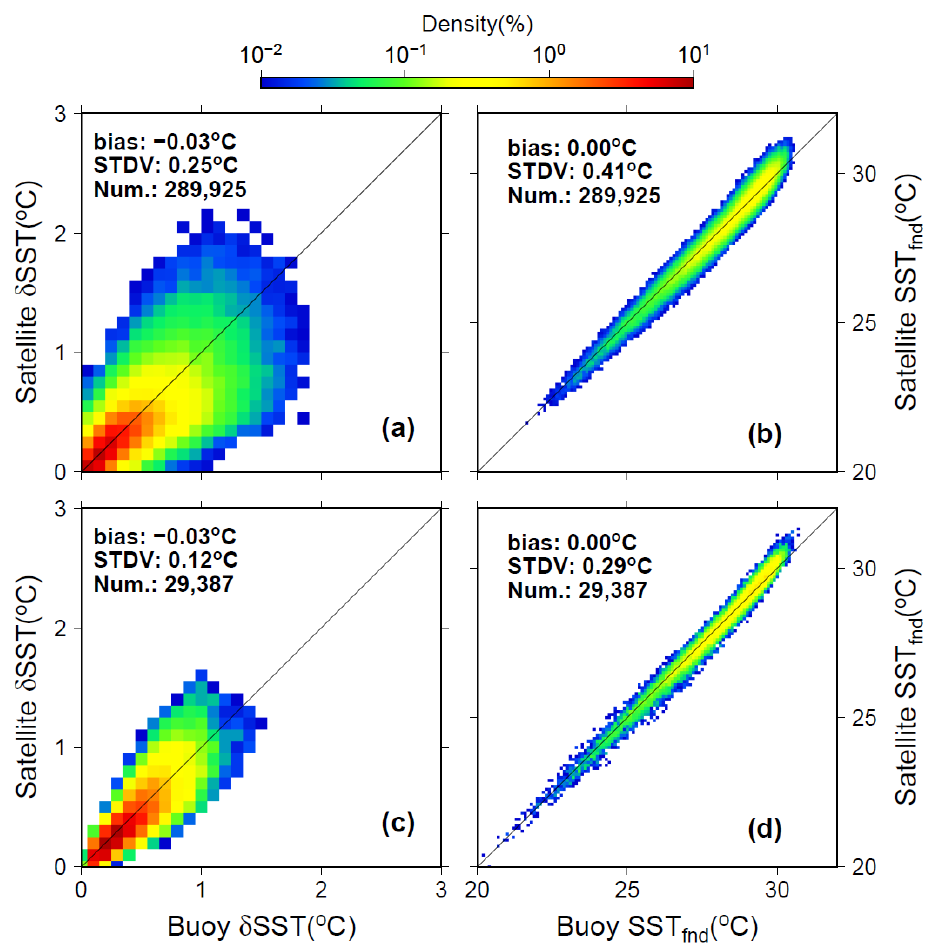
Figure 3. Frequency diagrams between satellite-based estimation and buoy observations of diurnal SST range ( δ SST, left column) and foundation SST (SST fnd , right column). Daily step data comparisons (( a ) and ( b )), and 10-day averaged data comparisons (( c ) and ( d )). The density was calculated by the number of data values in each 0.1 ◦ C × 0.1 ◦ C grid. The comparison was conducted for all data from 2003 to 2015.